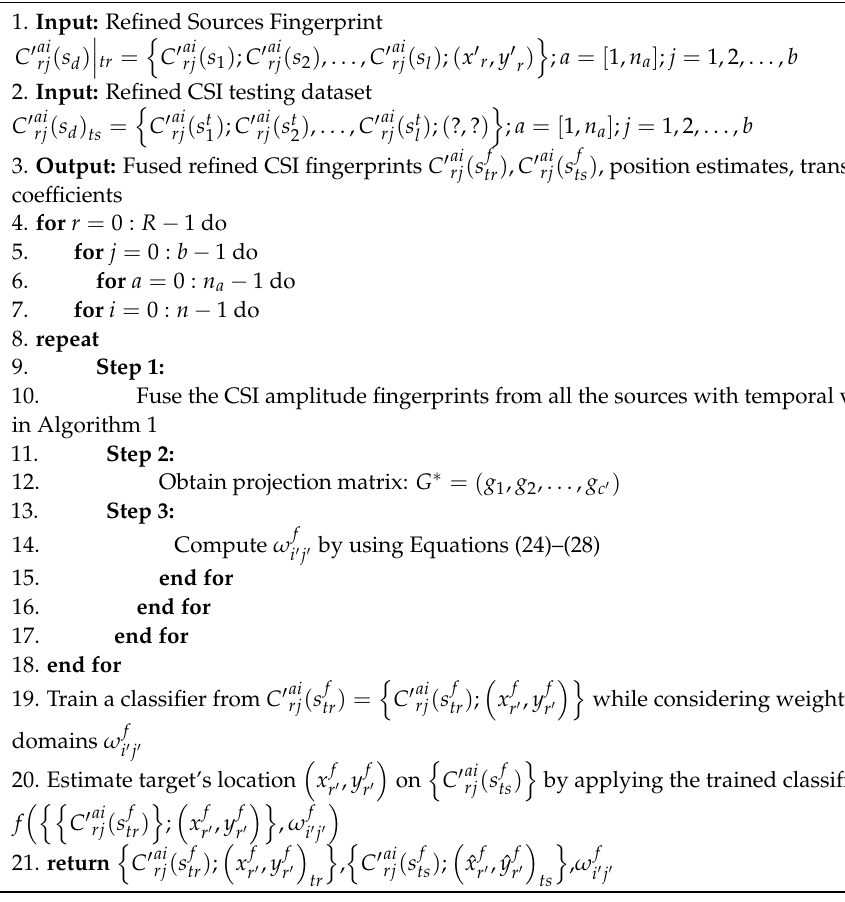
Algorithm 2 The proposed heterogenous knowledge transfer-based CSI-fingerprint indoor positioning